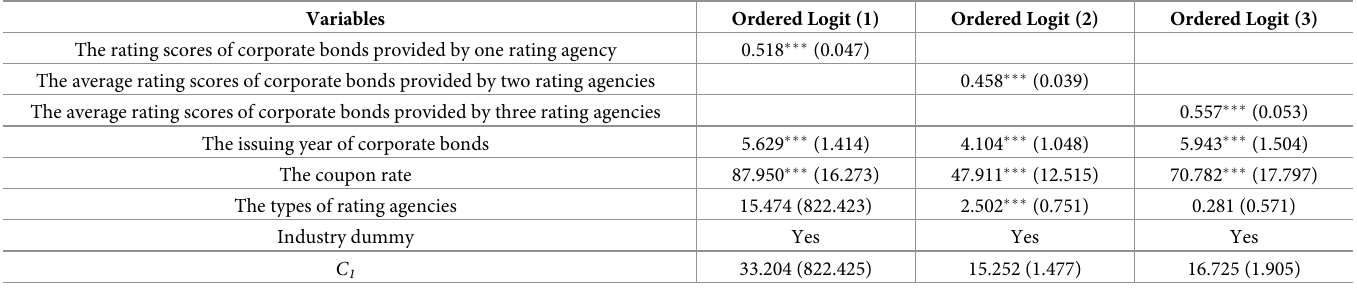
Table 6. Regression results of rating